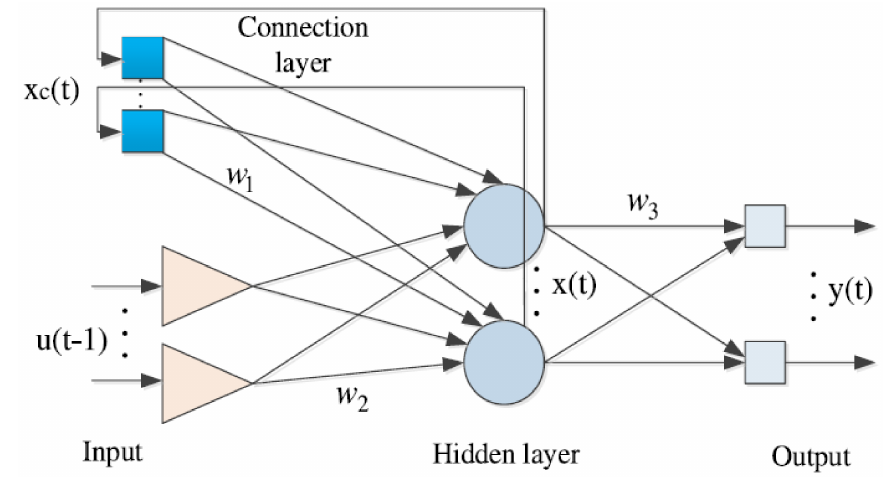
Figure 20. Elman Neural Network architecture